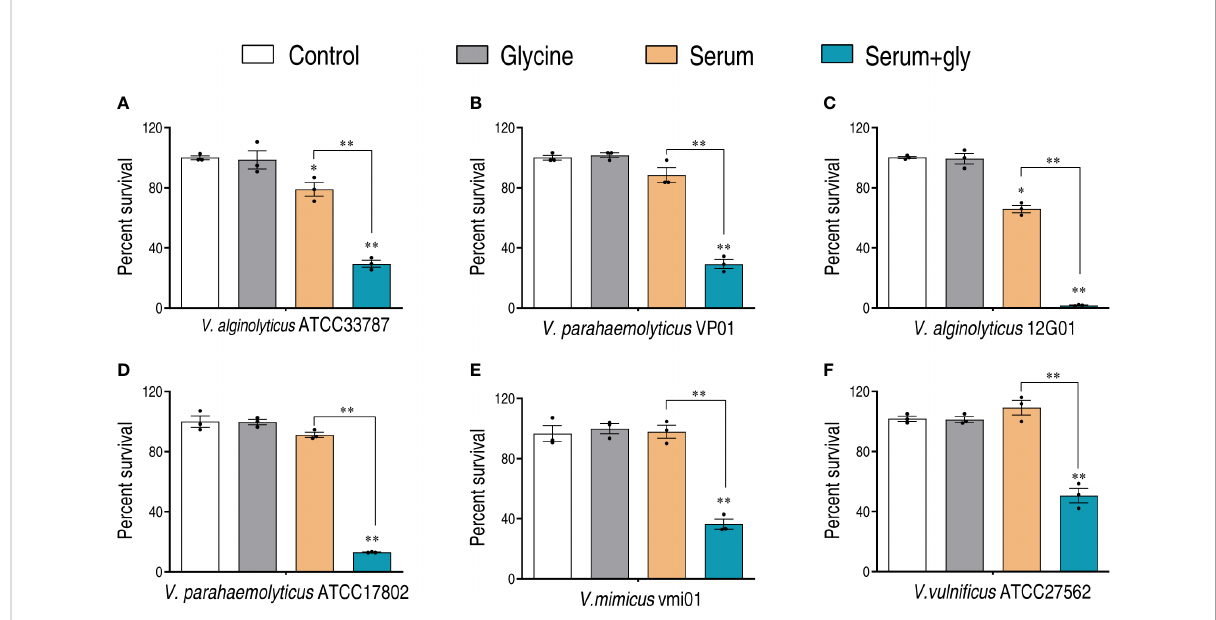
FIGURE 1 Glycine enhances serum killing to Vibrio . Percent survival of V. alginolyticus ATCC33787 (A) , V. parahaemolyticus VP01 (B) , V. alginolyticus 12G01 (C) , V. parahaemolyticus ATCC17802 (D) , Vibrio mimicus vmi01 (E) , and V. vulni fi cu ATCC27562 (F) in the presence of 100 mM glycine or/and 100 m l serum. The results are displayed as means ± SEM, and signi fi cant differences are identi fi ed (* p < 0.05; ** p < 0.01) as determined by Student ’ s t -test. At least three biological repeats were carried